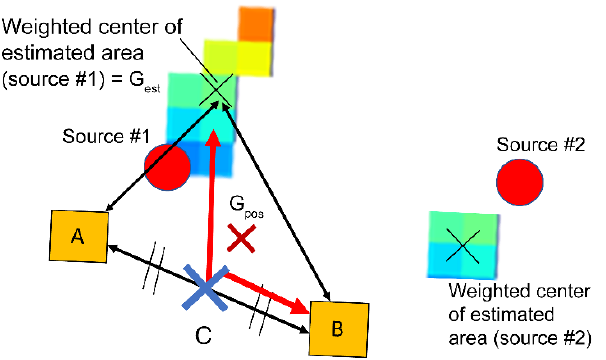
Figure 2. Definition of the candidates of features in the case that the weighted center of the estimated area of source #1 is closer to point C and chosen as the point G est .